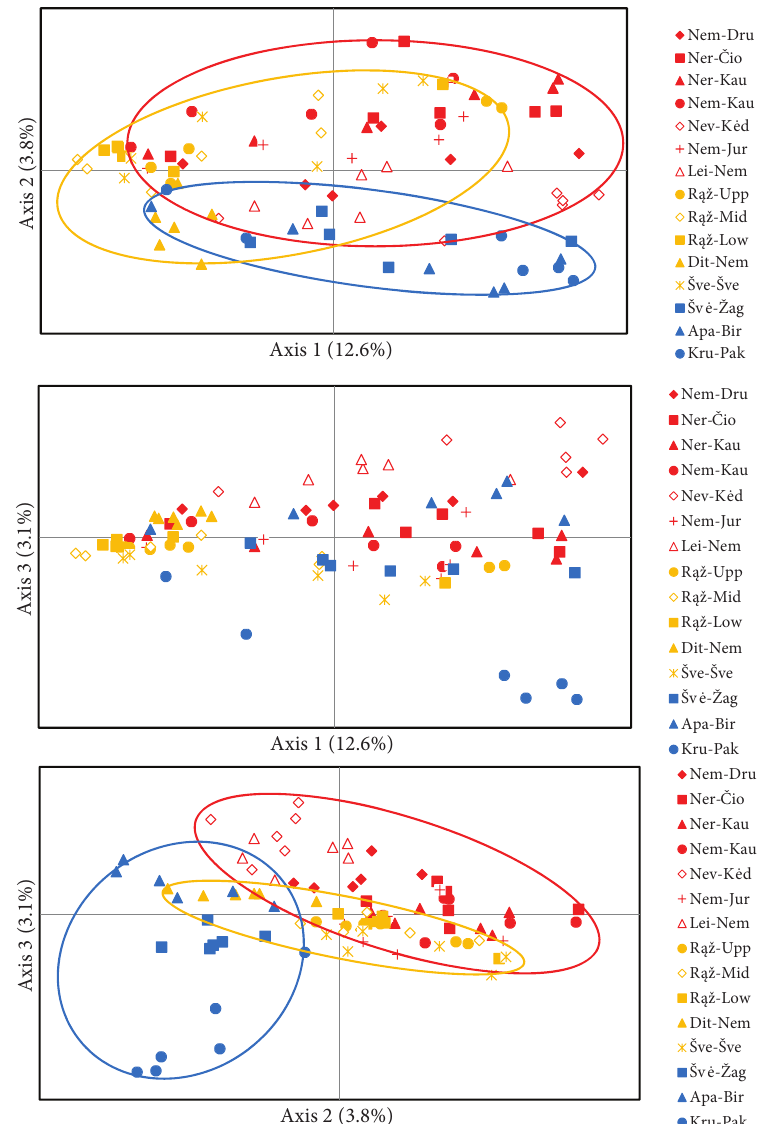
Figure 4. AFLP loci-based clustering patterns of 90 individuals of Lithuanian L. salicaria revealed by principal coordinate analysis (PCoA; principal components 1 vs 2; 1 vs 3; 2 vs 3). Yellow, blue and red colors separate